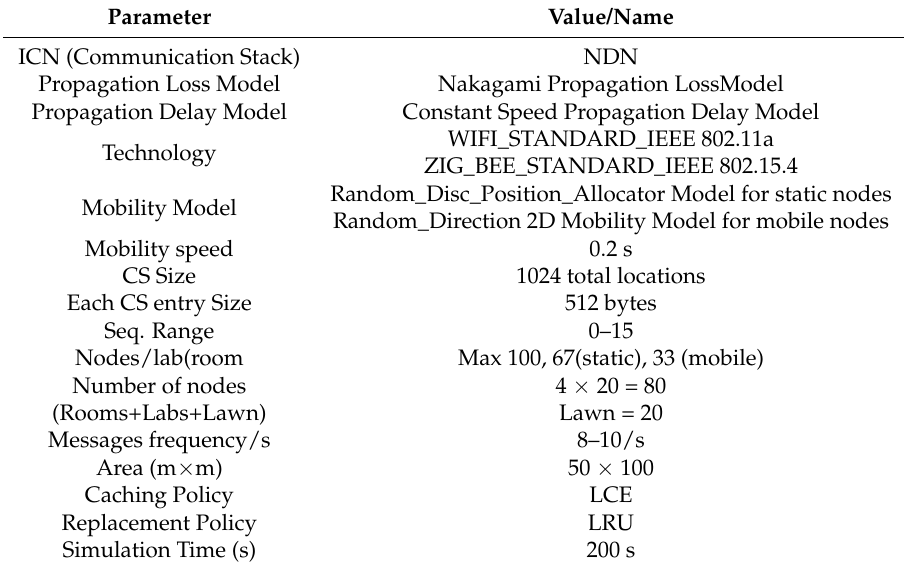
Table 3. Simulation